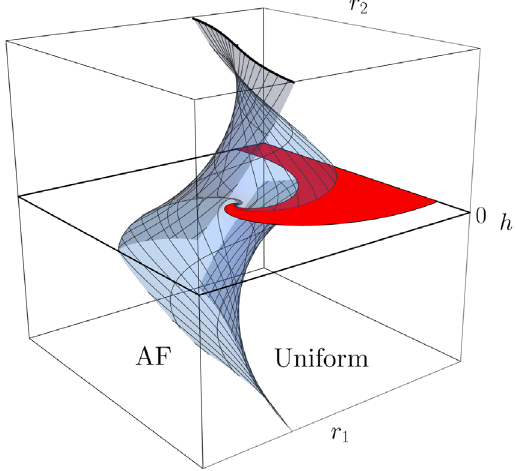
FIG. 7. Phase diagram for (one of the two) nonequilibrium tetracritical points as a function of effective mass terms and magnetic field. The transparent boundary indicates the location of an antiferromagnetic phase transition from a uniform phase. The horizontal (red) surface denotes a surface of first-order phase transitions. In both AF and uniform phases, the latter indicates a transition from a low- to a high-population phase; the sublattice population difference changes continuously across this surface. The (black) square boundary in the middle indicates the plane of h ¼ 0 . The diagram for the second nonequilibrium tetracritical point will spiral in the opposite